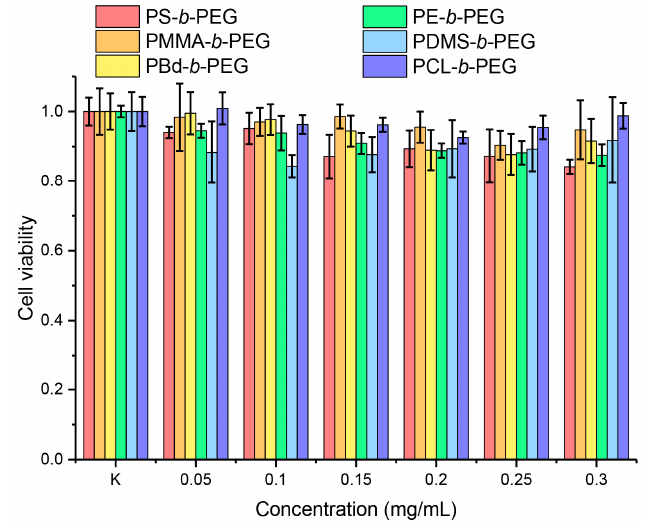
Figure 3. The viability of CHO-K1 cells after exposure to increasing concentrations of micelles for 24 h at 37 °C. Data are presented as mean ± standard deviation ( n = 12).